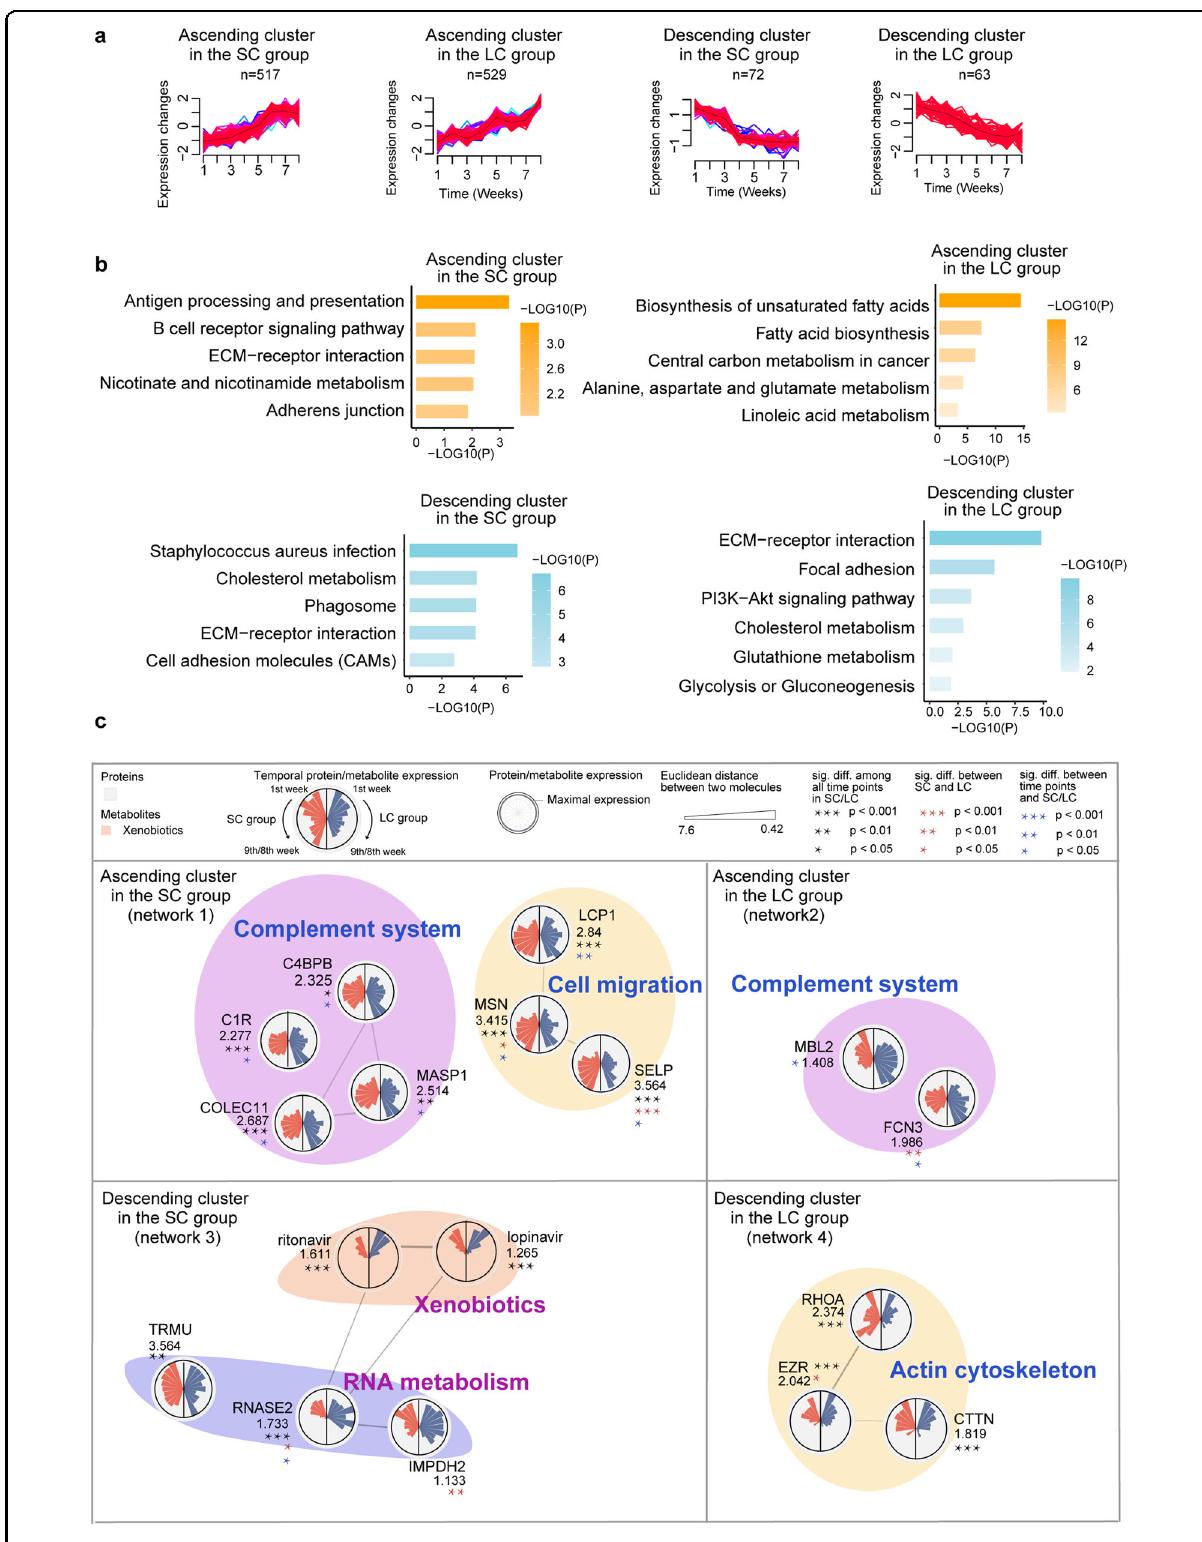
Fig. 5 (See legend on next